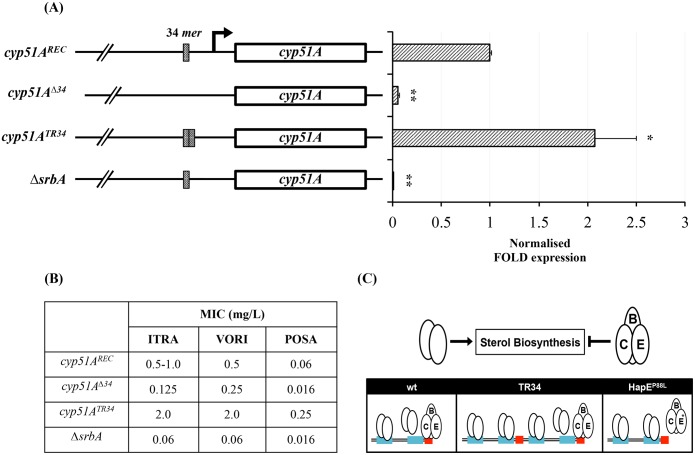
The 34 mer is essential for activation of cyp51A gene expression and azole resistance.(A) cyp51A transcript levels in strains lacking the 34 mer (cyp51A
Δ34) and strains carrying TR34 (cyp51A
TR34) have been measured using RT-qPCR (gpdA was used as reference gene). Strains for the expression analysis have been grown in AMM for 18h at 37°C, 200 rpm. Samples have been assessed in biological duplicates. Error bars indicate the standard deviation of respective samples. p-values were calculated by Student’s T-test (reference: cyp51A
REC): *, <0.05; ** <0.01; (B) MIC levels of itraconazole (ITRA), voriconazole (VORI) and posaconazole (POSA); (C) Proposed model highlighting the mechanistic basis of the 34 mer associated azole resistance in the promoter of cyp51A. In susceptible isolates (wt) SrbA homodimers bind to SRE1 and SRE2 thereby activating expression of cyp51A. The CBC competes with SrbA binding to the 34 mer. In resistant isolates, carrying the duplicated 34 mer (TR34), both SREs are duplicated whereas only the CGAAT motif located at the 3’ end of the 34 mer is effectively bound by the CBC. Upregulation of cyp51A in resistant isolates expressing mutated hapE (hapE
P88L) is caused by decreased binding affinity of the mutated complex. Hence, CBC-based competition with SrbA is perturbed enhancing binding of SrbA to the 34 mer.